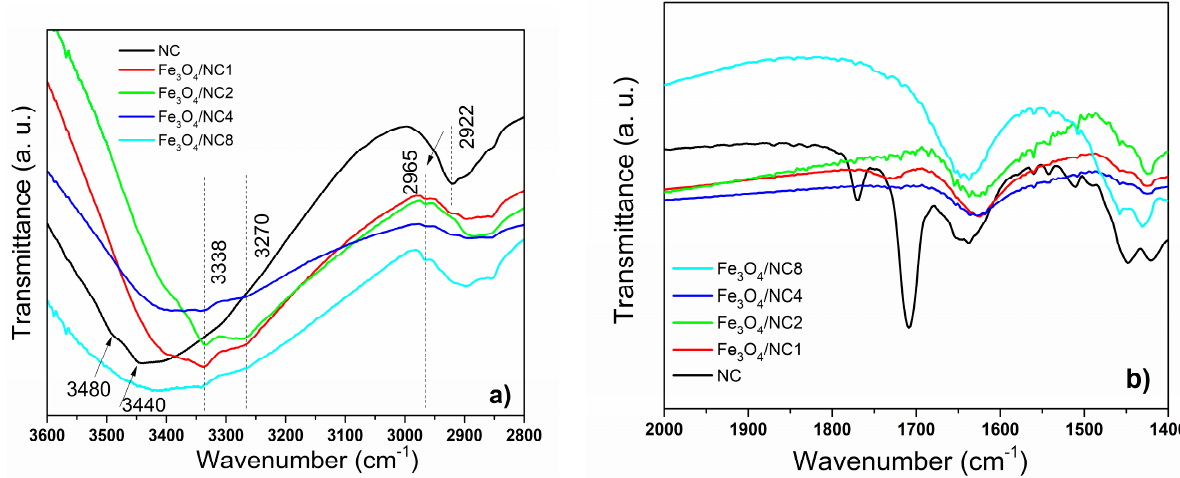
Figure 3. FTIR spectra of the NC and all modified samples: ( a ) 3600–2800 cm − 1 wavenumber range and ( b ) 2000–1400 cm − 1 wavenumber range.